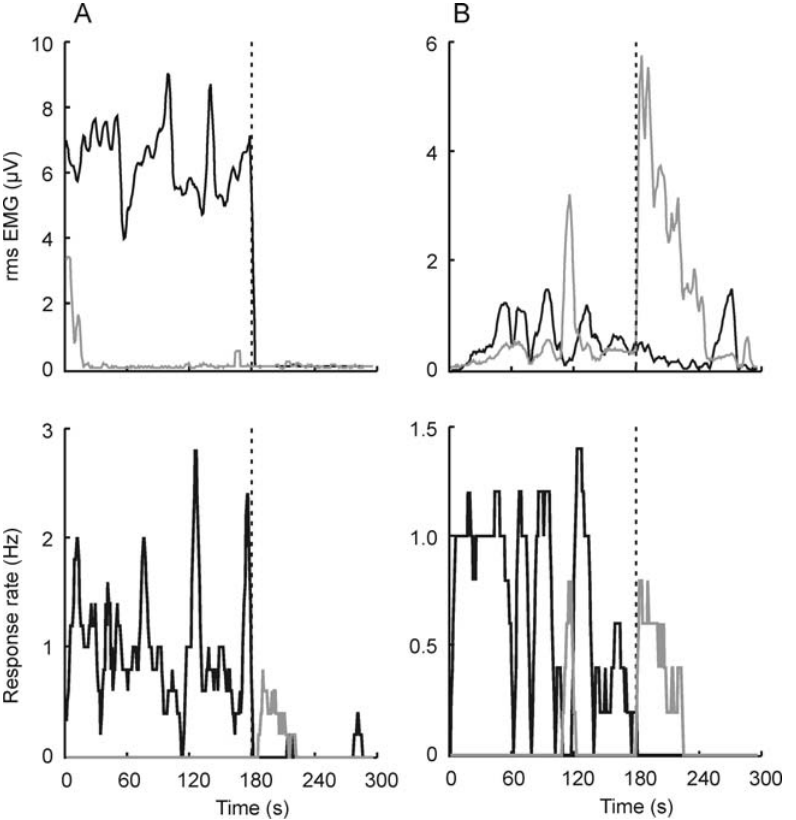
Figure 5. EMG records (top) and perceptual experience (bottom), individual data of two participants. Black line represents activity in the triceps and illusory extension, and grey line, biceps activity and illusory flexion. Data on the left (Participant 6 from Table 2) show positive correlation between biceps activity and the illusory extension (r=0.60) and no other associations. Data on the right (Participant 1) show correlation between activity in the triceps and illusory extension (r=0.51), as well as between the biceps and illusory flexion (r=0.90).